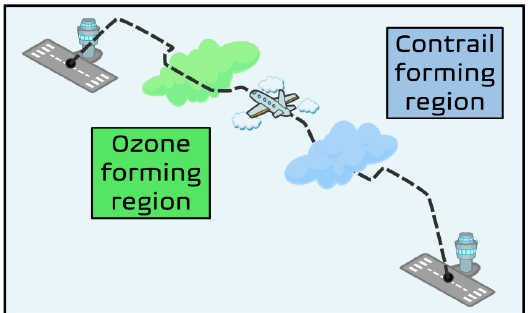
Figure 1. Conceptual representation of an aircraft trajectory optimised for minimum climate